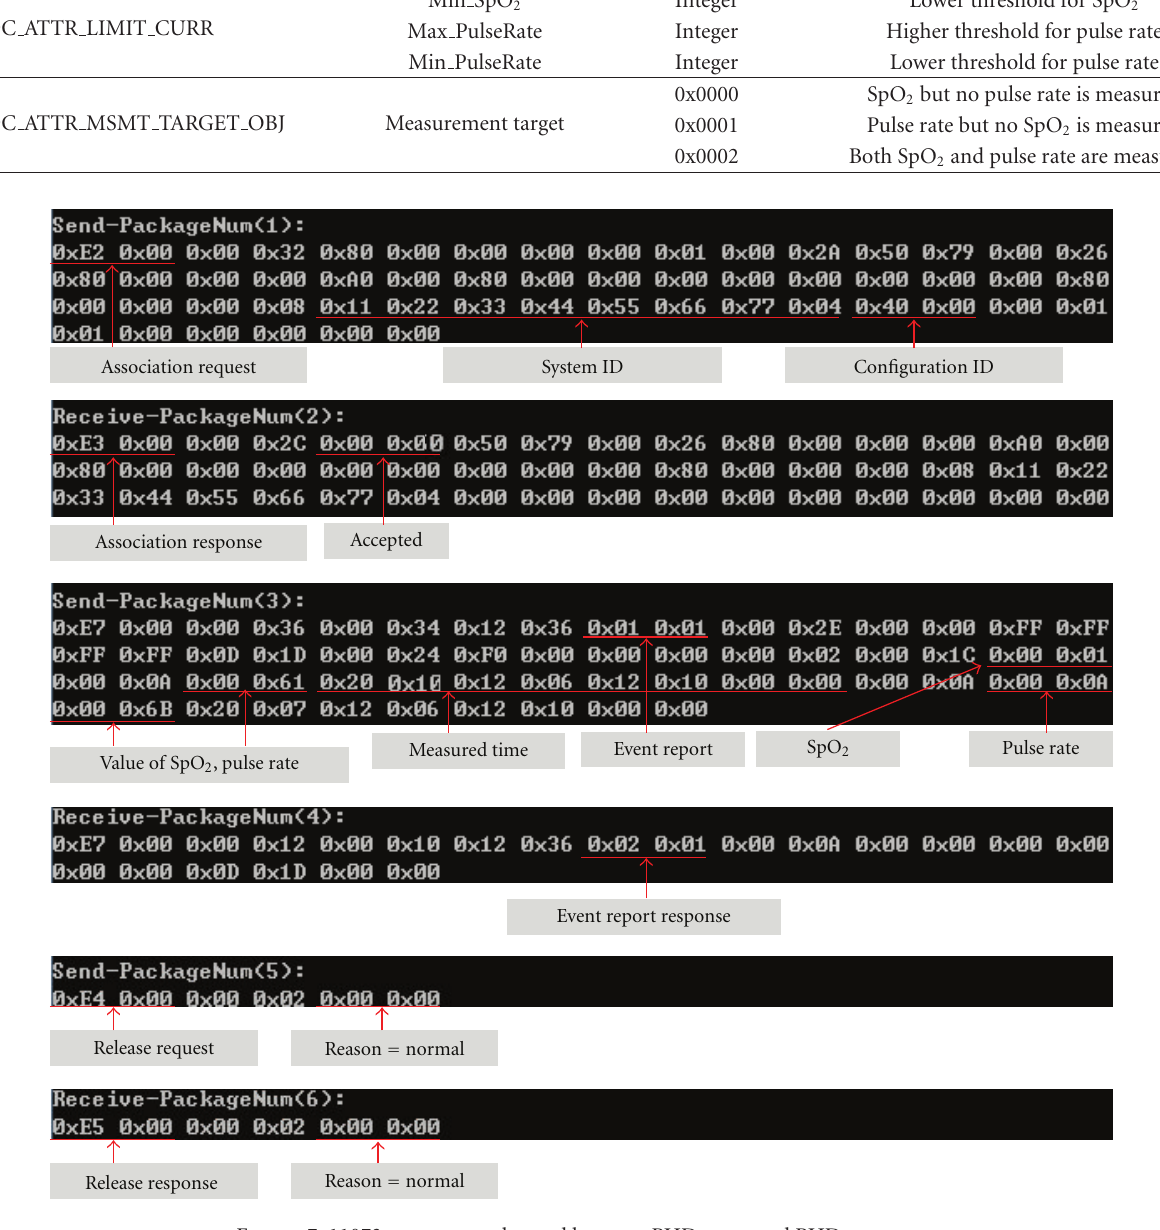
Figure 7: 11073 messages exchanged between PHD agent and PHD